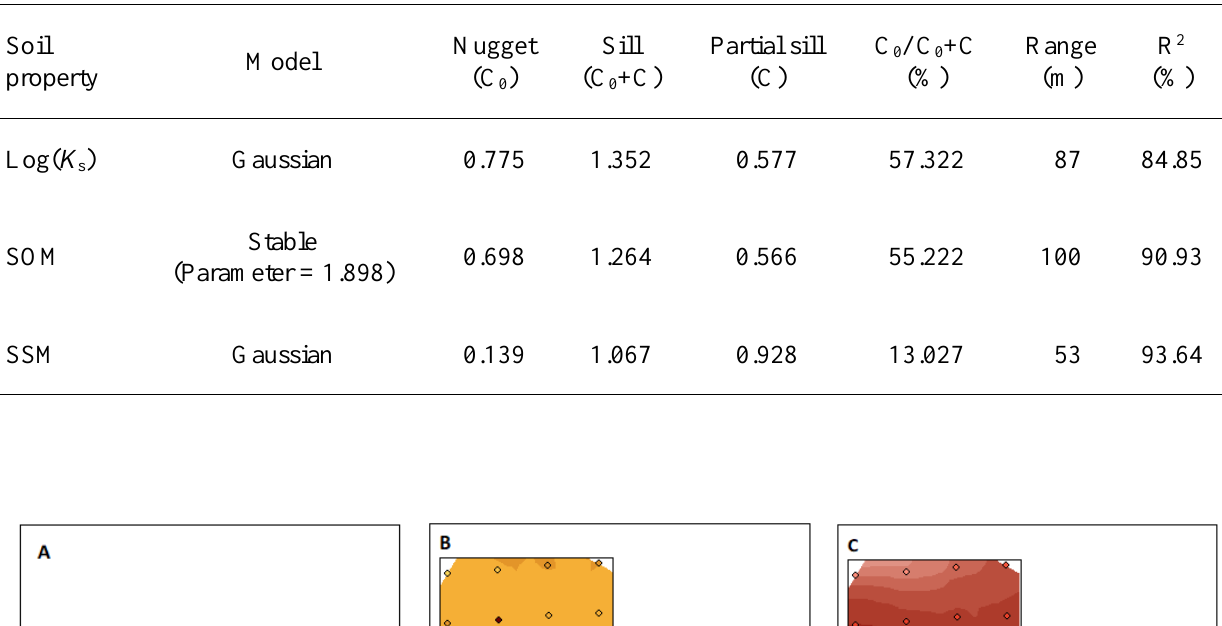
Table 3. Variogram models and parameters for SOM and log( K s ).